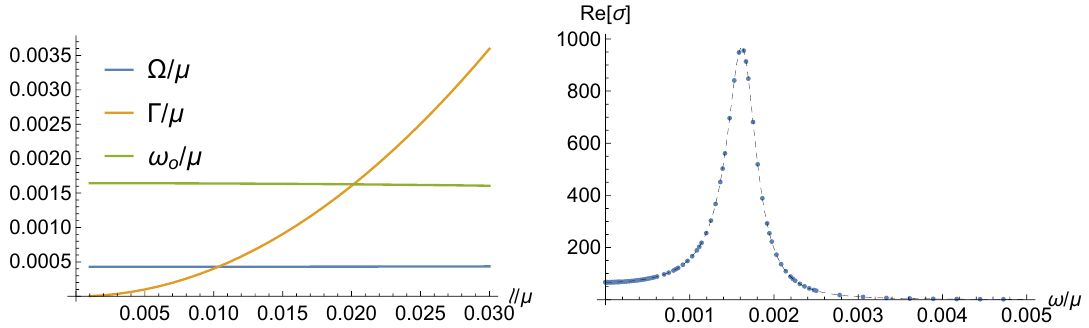
Figure 7 . ( (cid:21)=(cid:22); k=(cid:22); T=(cid:22) ) = (0 : 0002 ; 0 : 1 ; 0 : 1). Left: ‘ dependence of the relaxation parameters extracted from the two lightest QNMs and the dc conductivity. Right: real part of the ac electric conductivity computed numerically (blue dots) together with the hydrodynamic prediction (4.2) (black dashed line) for ‘=(cid:22) = 0 : 001.